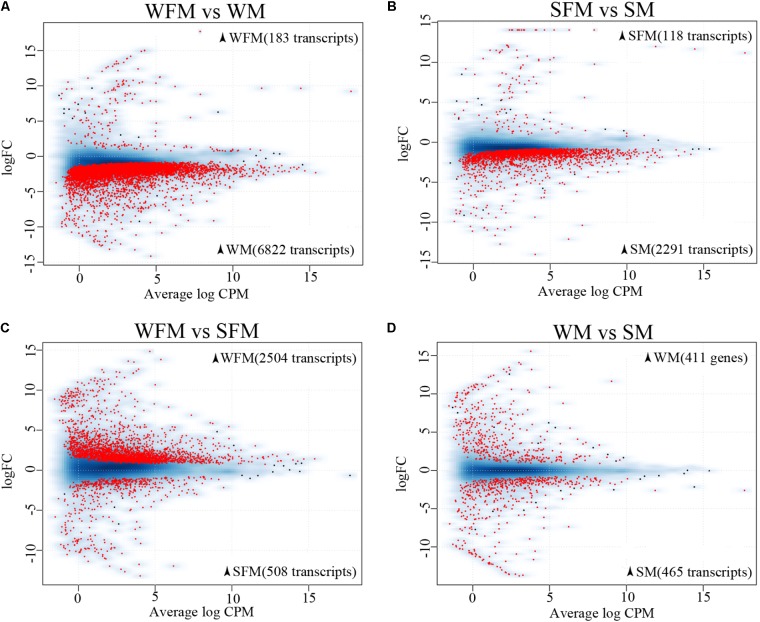
Global analysis of gene expression profiling. (A–D) Two-dimensional scatter diagram showing the number of differentially expressed genes (FDR <0.5) in red in each pairwise comparison. Wildtype female (WFM), wildtype male (WM), stat5b-mutated female (SFM), stat5b-mutated male (SM). A smooth scatter was used to convert the number of points in each plot coordinate into a vector of colors representing the local point density. Darker shades of blue represent higher density of point. Only below a specific density or in case of significance the dot is drawn. The numbers of sex-biased genes in the respective type of fish were shown in brackets.